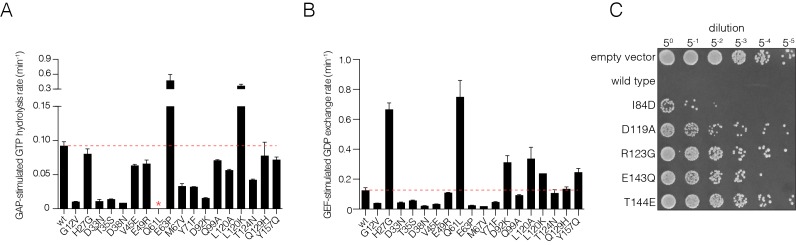
Validation of mutational effects through in vitro biochemical measurements of GAP- and GEF- stimulated nucleotide hydrolysis and exchange rates and a yeast growth assay.(A) GAP-stimulated GTP hydrolysis rates for a panel of Ras mutants, as measured by a fluorescent sensor for inorganic phosphate release upon hydrolysis of GTP to GDP. Mutations in Switch I (residues 28–40) directly affect GAP binding and lead to reduced GTP hydrolysis rate. (B) GEF-stimulated GDP exchange rates for a panel of Ras mutants, as measured by fluorescent-nucleotide release. Mutants in Switch II (residues 59–76) directly affect GEF binding and lead to reduced GDP release rates. (C) S. cerevisiae Ras assay for mutations that result in a loss-of-function in the bacterial two-hybrid system. Yeast cells are transformed with human Ras mutants and are assayed for growth after heat shock. Colony growth is measured upon plating five-fold serial dilutions of yeast cultures after heat shock for various Ras mutants. Wild-type human Ras renders the yeast cells highly sensitive to heat shock. Mutants that destabilize Ras by impairing nucleotide binding lessens sensitivity to heat shock and result in increased cell growth.